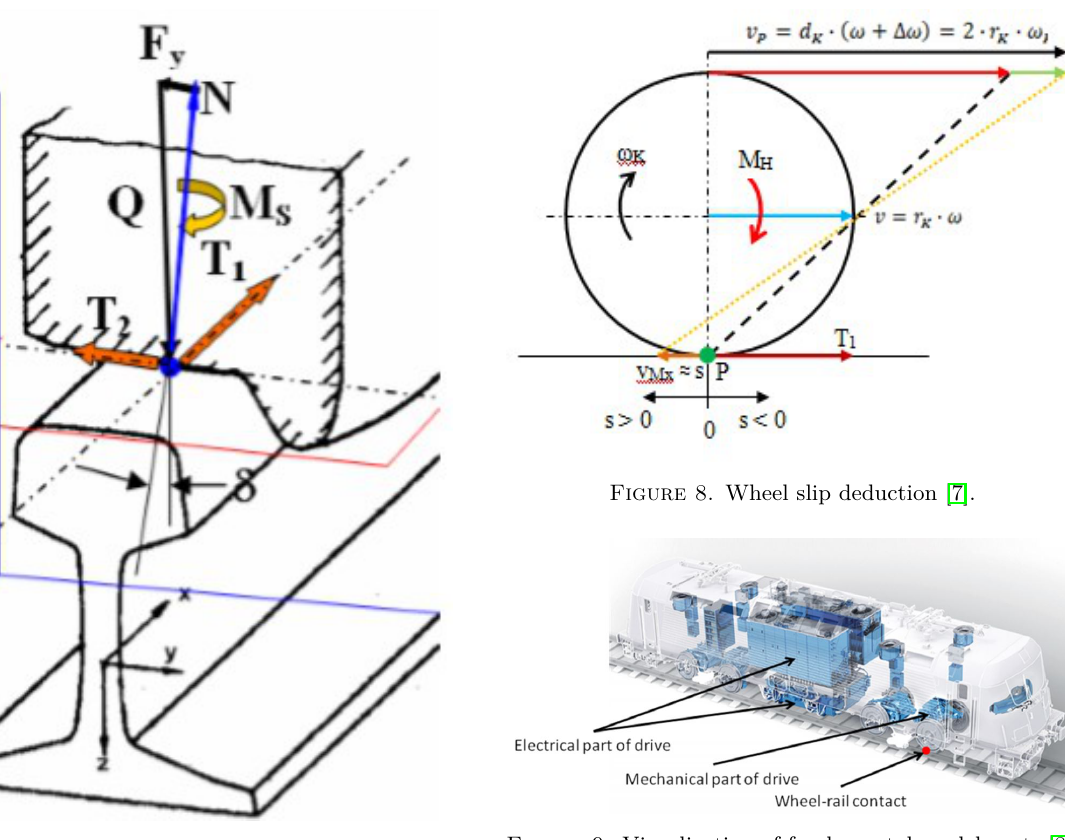
Figure 7. Wheel-rail contact forces [7].